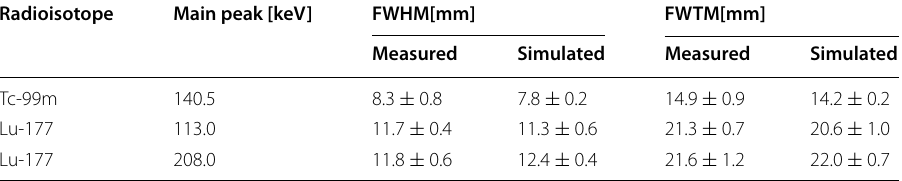
All parameters have been measured at distance of 10 cm from collimator